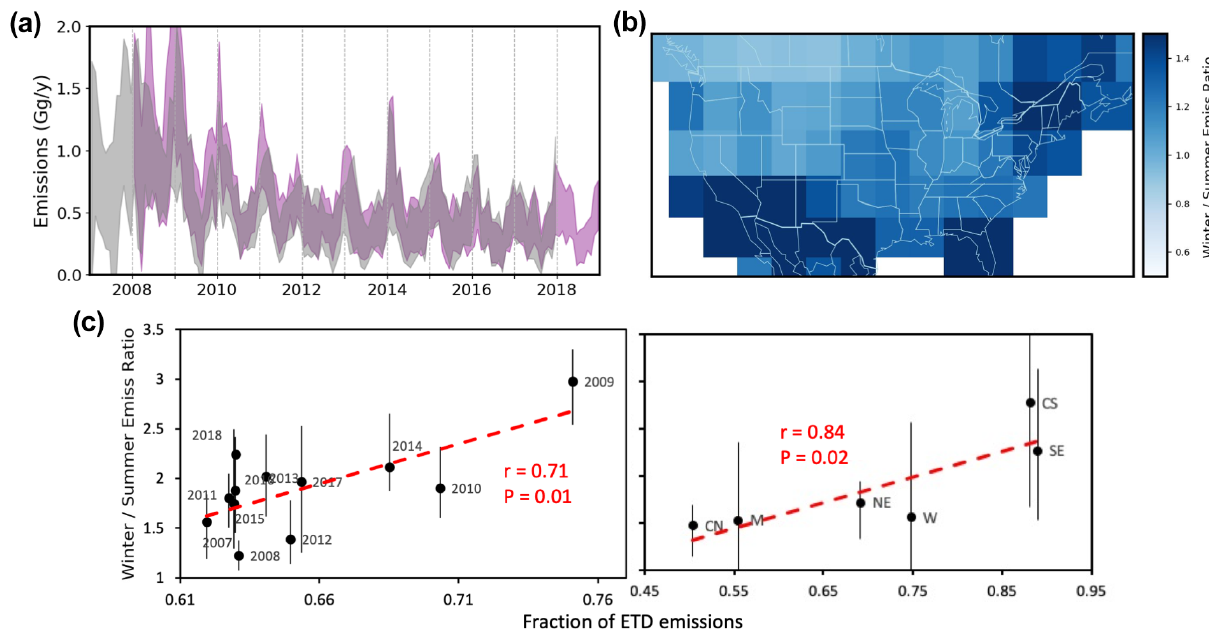
Figure 3. Seasonal cycle of US SF 6 emissions derived from atmospheric observations. (a) Monthly emissions derived from atmospheric inversions using HYSPLIT–NAMS (in purple shading) and WRF–STILT (in gray shading) transport simulations. The shading associated with each transport model represents a combined uncertainty associated with six different inversions. (b) The winter-to-summer emission ratios derived on a 5 ◦ × 5 ◦ grid from atmospheric observations, averaged across all years and 12 inversion ensemble members. The winter and summer here are defined as November–February and May–August, respectively. (c) Atmosphere-derived winter-to-summer emission ratios versus the fraction of total US SF 6 emissions from electric power transformation and distribution (ETD) reported by EPA. Left: the ETD emission fraction versus winter-to-summer emission ratios for annual national emissions; error bars indicate the 2.5th–97.5th percentile range from the 12 inversion ensembles. Right: the mean ETD emission fraction by region averaged between 2007–2018 versus winter-to- summer emission ratios for multi-year average regional emissions over the same period; error bars indicate the 2.5th–97.5th percentile range from the 12 inversion